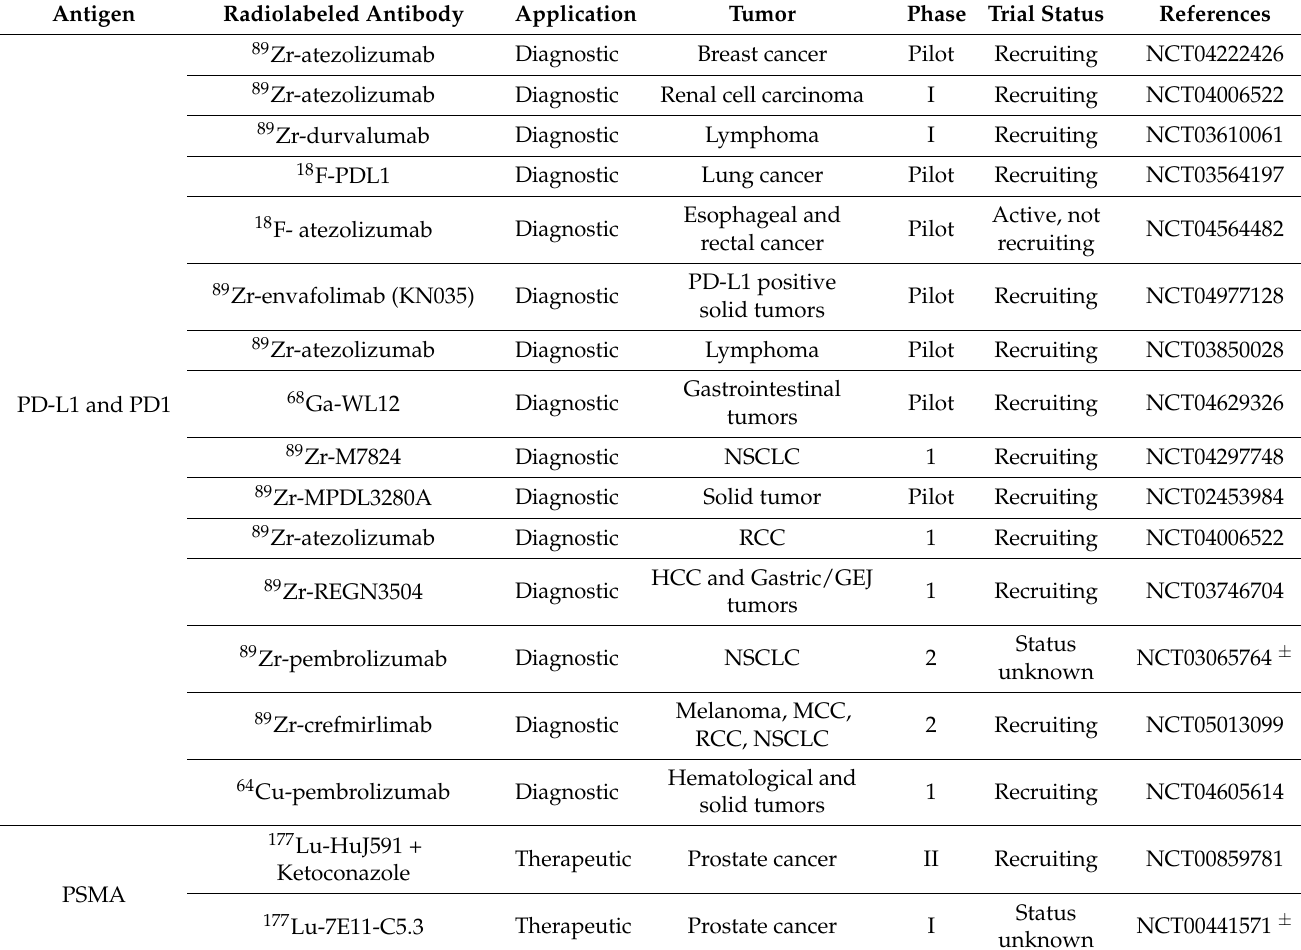
Table 1. Examples of clinical trials evaluating radiolabeled antibodies for imaging and therapy. Antigen Radiolabeled